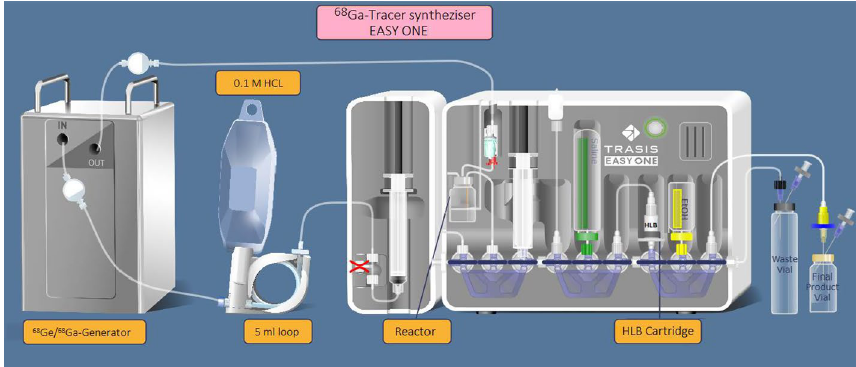
Fig. 2 Automated synthesizer of [ 68 Ga]Ga-FAPI-46 (EasyOne;